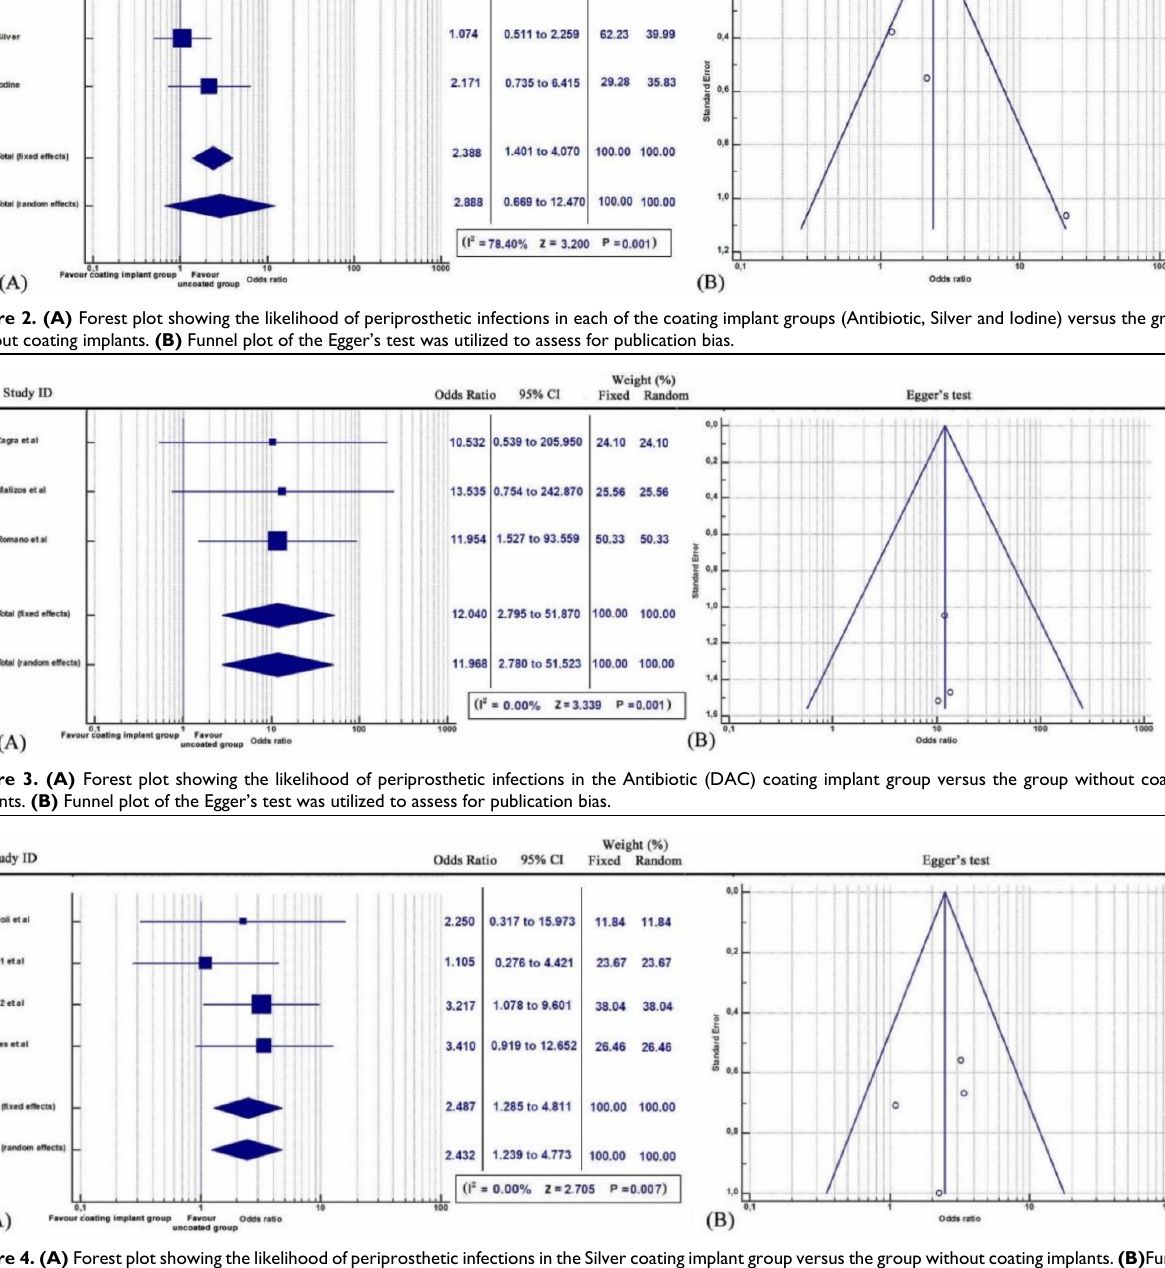
Figure 4. (A) Forest plot showing the likelihood of periprosthetic infections in the Silver coating implant group versus the group without coating implants. (B) Funnel plot of the Egger’s test was utilized to assess for publication